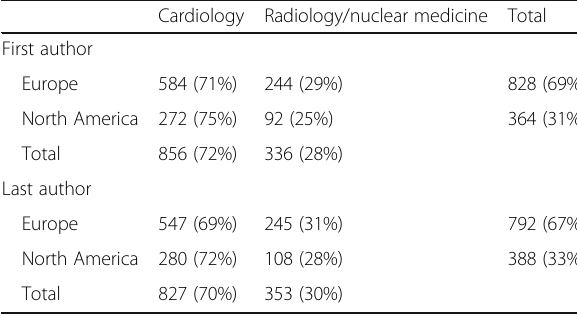
Table 2 Authorship by institution location for articles published by cardiologists or radiologists/nuclear medicine physicians